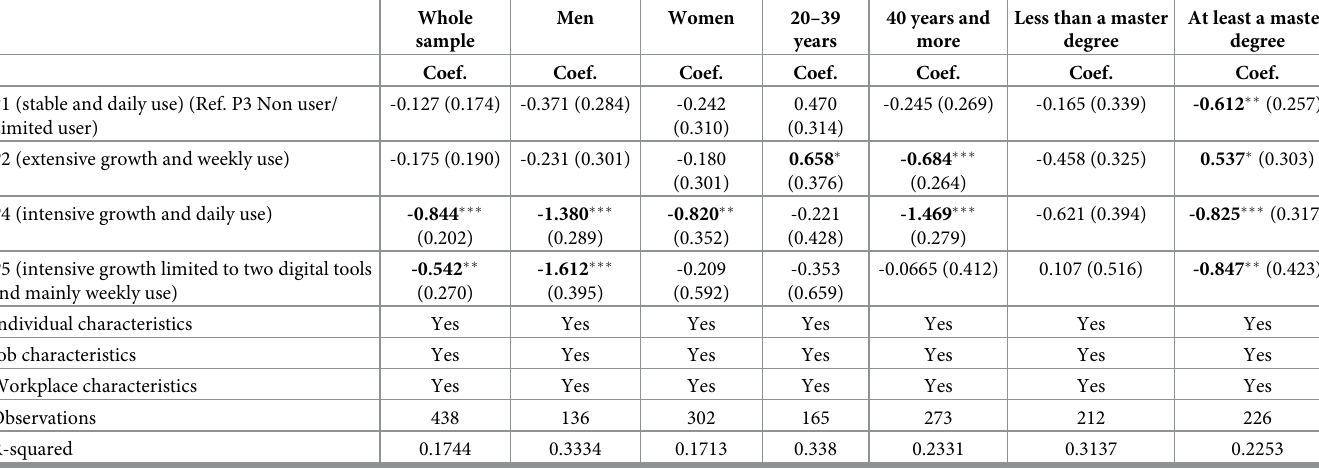
Table 4. Collaborative and communication digital profiles and the evolution of job satisfaction before and during the lockdown by sub-samples (ordered probit model).